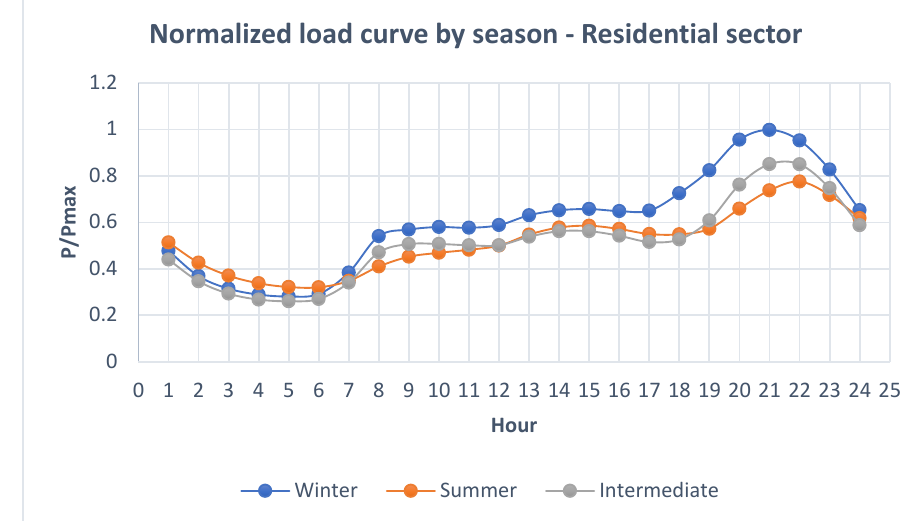
Figure A2. Residential load curve for different model seasons.